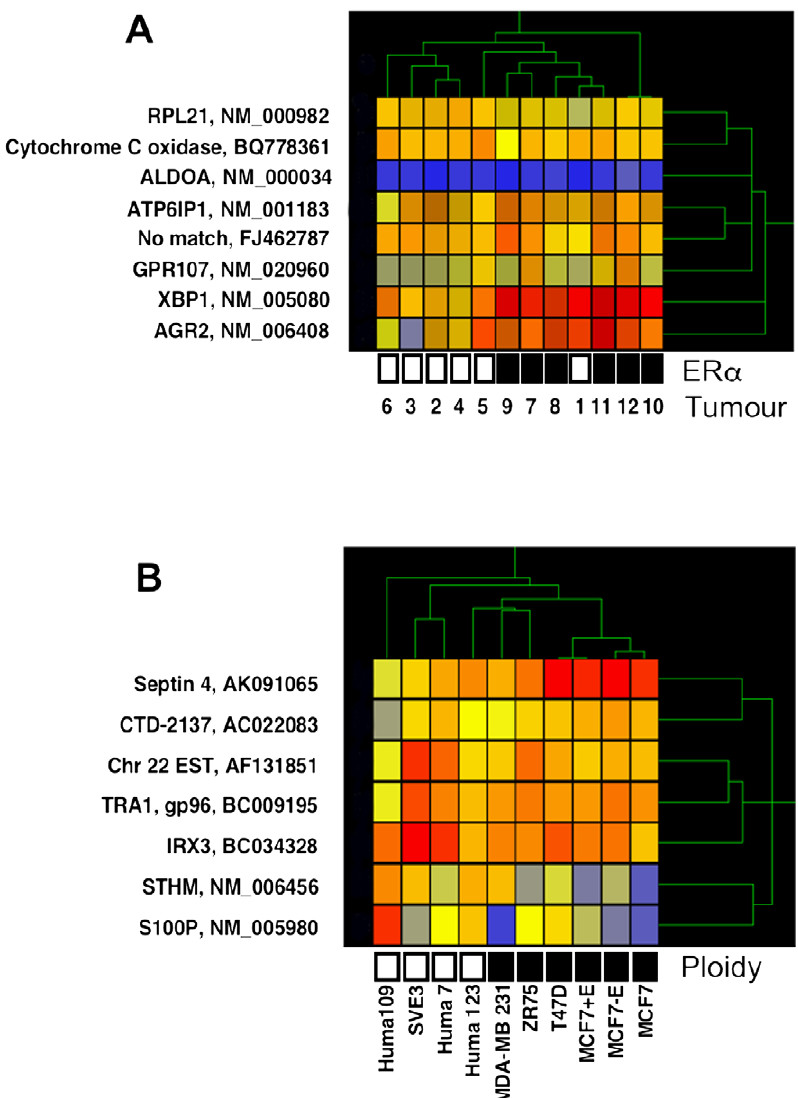
Fig. 1. Clustering of tumour samples (A) and cell-lines (B) based on gene lists from class-prediction for either ER α status (A, 8 genes) or ploidy (B, 7 genes): dendograms represent hierarchical clustering of genes (right) and samples (top) using Pearson correlation as a similar- ity measure. ER α : black boxes are ER α protein positive tumour samples; white boxes are ER α protein negative tumour samples. Ploidy: black boxes are aneuploid cell-lines; white boxes are diploid cell-lines. The listed genes are: (A) NM_000982, Human ribosomal protein L21 (RPL21); BQ778361, EST match to Cytochrome C oxidase; NM_000034, fructose bisphosphate aldolase A (ALDOA); NM_001183, Hu- man ATPase, H + transporting, lysosomal accessory protein 1 (ATP6AP1); FJ462787, novel clone no match in database; NM_020960, G pro- tein-coupled receptor 107 (GPR107); NM_005080, X-box binding protein (XBP-1); NM_006408, anterior gradient 2 (AGR2); (B) AK091065, Human septin 4 nucleotide binding protein; AC022083, Human chromosome 15 clone CTD-2137J4; AF131851, Chr 22 EST, Human family with sequence similarity 19 (chemokine (C–C motif)-like), member A5 (TAFA5); BC009195, Human heat shock protein 90 kDa beta (Grp94), member 1 (HSP90B1); BC034328/NM_02433, Human iroquois homeobox protein 3 (IRX3); NM_006456, Human ST6 (al- pha-N-acetyl-neuraminyl-2,3-beta-galactosyl-1,3)-N-acetylgalactosaminide alpha-2,6-sialyltransferase 2; NM_005980, S100 calcium binding protein P (S100P). Colouring according to relative expression: red – higher, blue – lower, yellow –